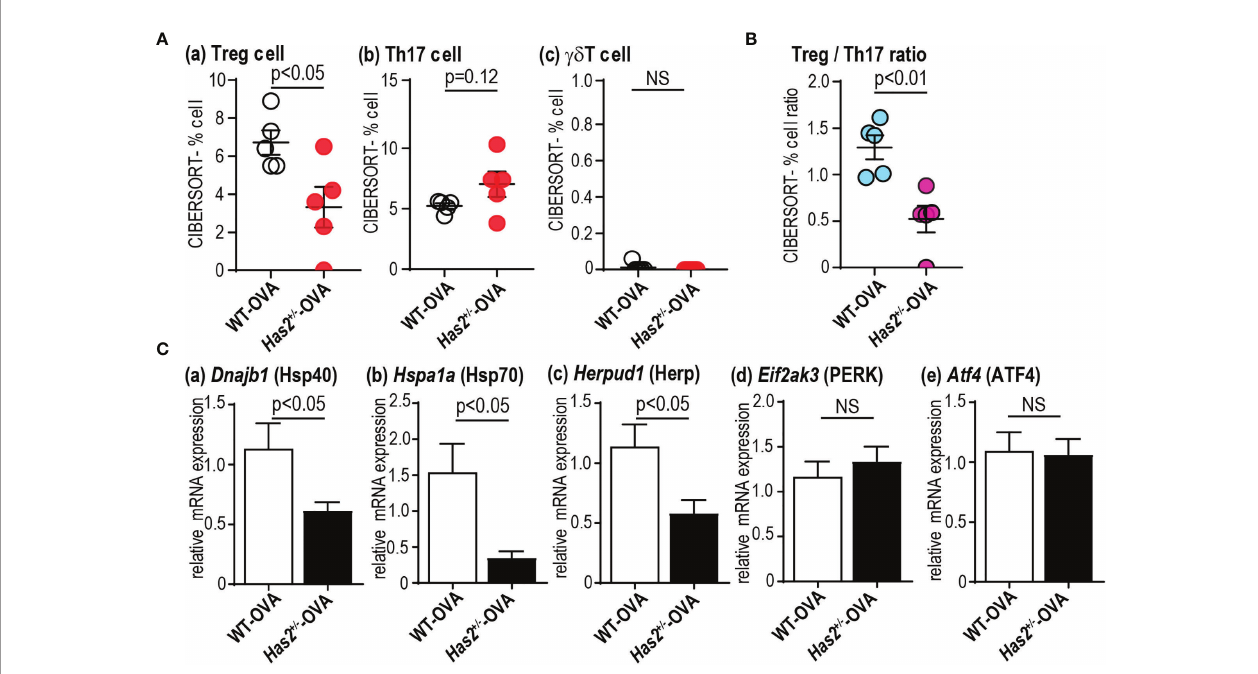
FIGURE 5 | Has2 attenuation induces Th17/Treg imbalance and attenuation of ER stress response-related molecules. Semiquantitative evaluation of immune cell in fi ltrates (A) and Treg/Th17 ratio (B) after the OVA stimulation as determined by CIBERSORT analysis on whole-lung RNA-seq data ( n = 5). (C) Levels of mRNA transcripts encoding Dnajb1 , Hspa1a , Herpud1 , Eif2ak3 , and Atf4 ( n = 9 – 10). All samples are obtained 24 h after the fi nal challenge with OVA. Statistical signi fi cance was determined using the Mann – Whitney U test. Horizontal bars indicate direct statistical comparisons between WT and Has2 +/ − mice. NS, not signi fi